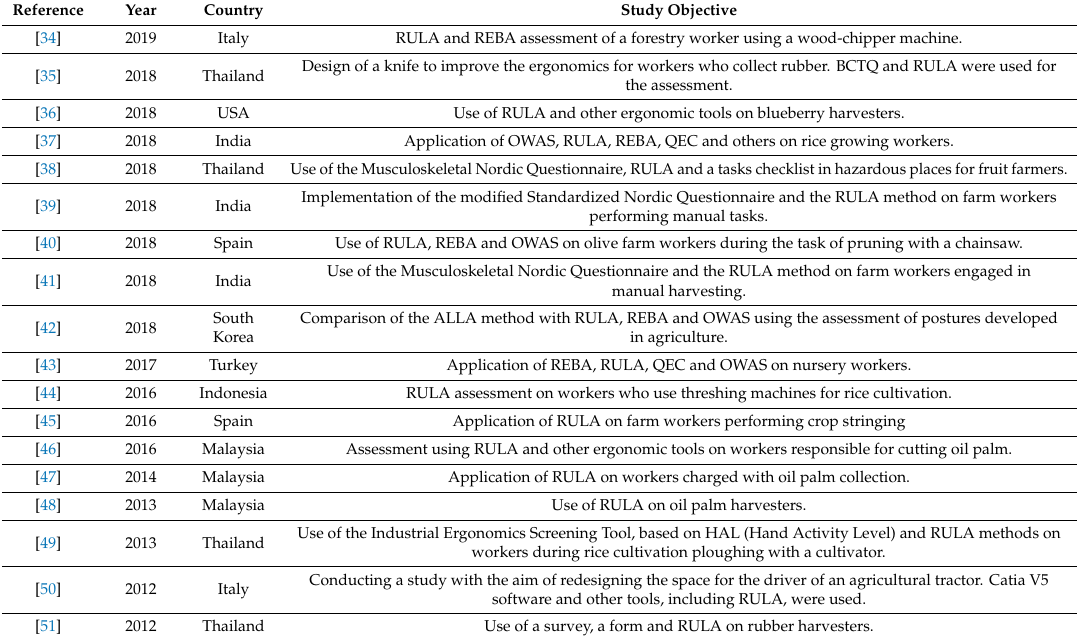
Table 3. Agriculture, forestry and